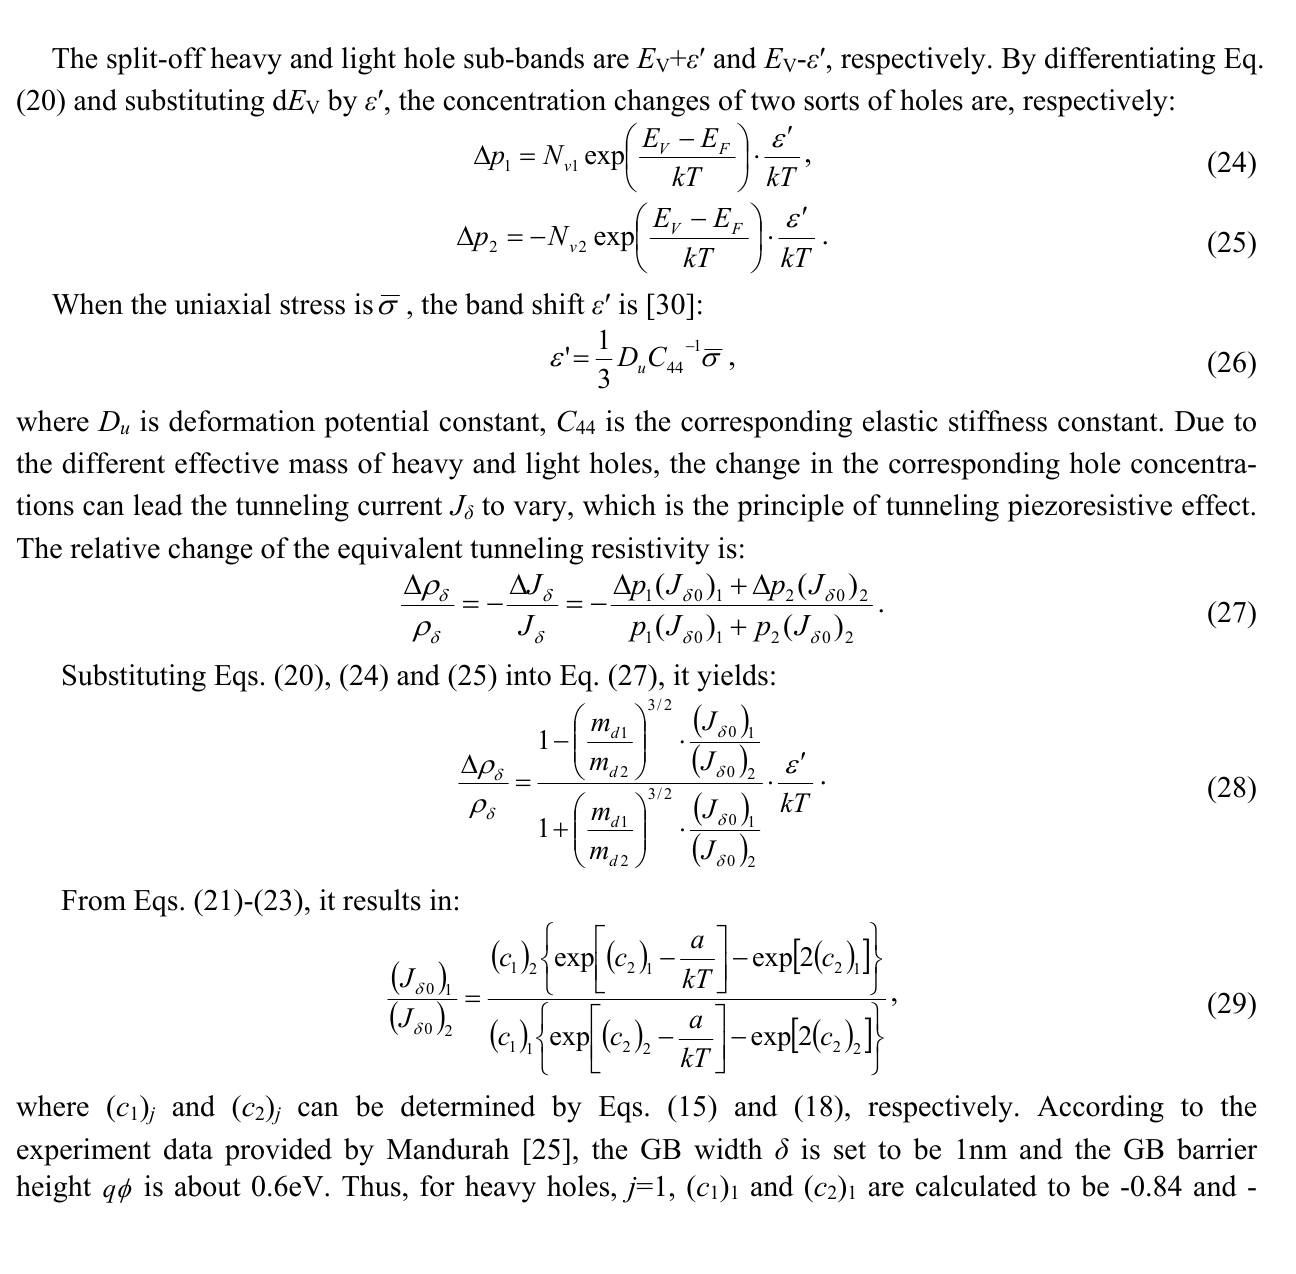
Table 1. Hole effective mass in highly stressed silicon (unit: free-electron mass m m l1 0.870